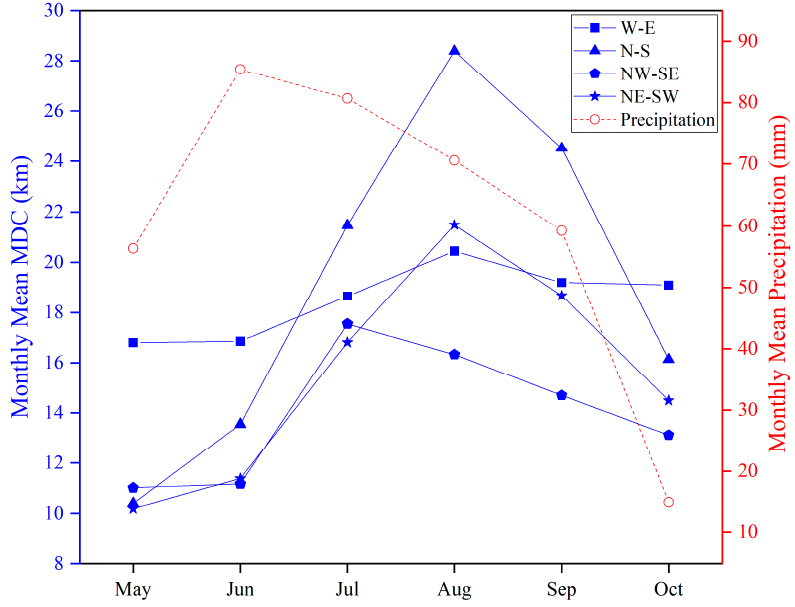
Figure 17. The relationship between monthly mean maximum distance of connection (MDC) and mean monthly precipitation in the Momoge National Nature Reserve, China from 2015 to 2019. The time series imagery established by combining geostatistical analysis and remote sensing methods reflect the distribution, flow paths and connection process of the MNNR connectomes